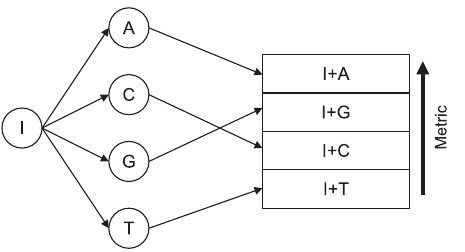
Fig.9|PrincipleofoneiterationofthestackalgorithmforDNA:aninputnode I is extended for each of the possible bases (A, C, G, and T) at the current position. Thenewdecodingbranches( I +A, I +G, I +C,and I +T)aretheninsertedinto the decoding stack, and the stack is sorted according to the branch metrics. The node(s) with the highest metric in the stack will be extended in the next